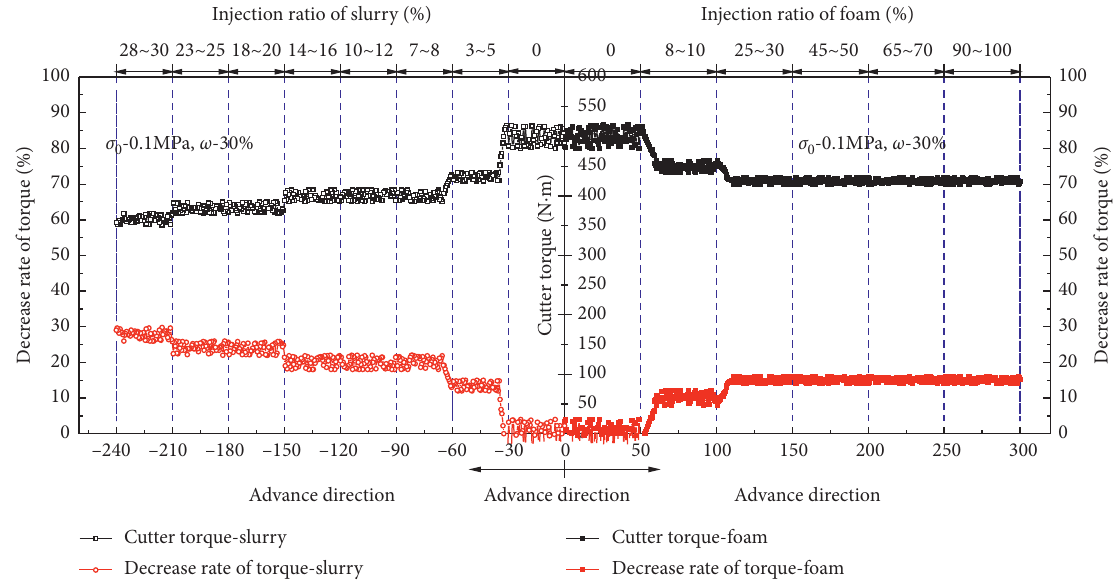
Figure 28: Effect of two types of soil conditioners on cutter torque at water content 30% and soil pressure 0.1MPa.